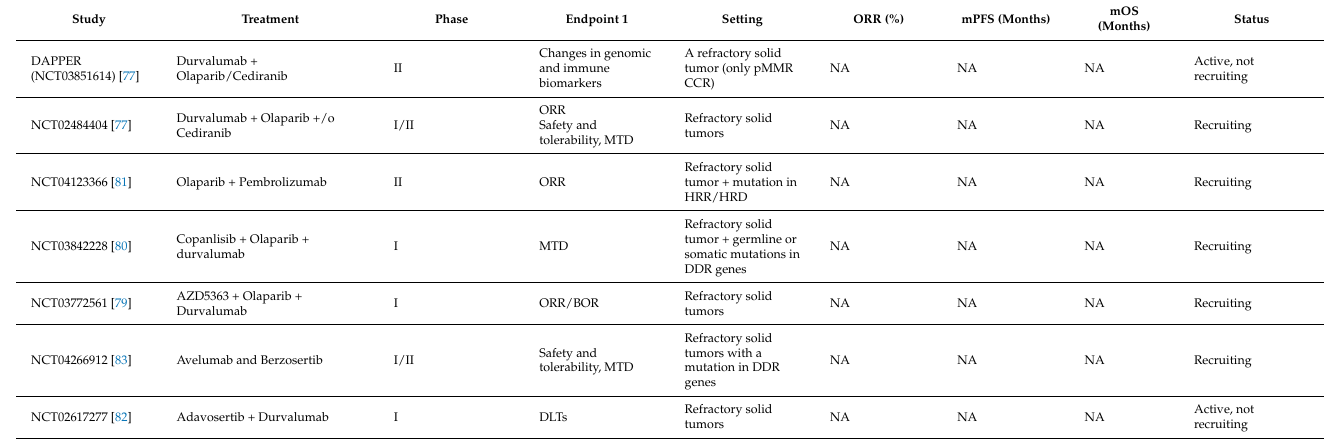
Table 5. Currently ongoing and completed clinical trials of DDR inhibitors and ICIs in MSS